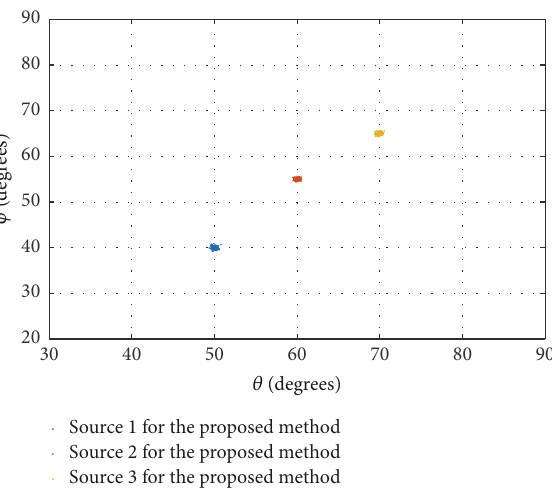
Figure 10: Scatter plot for the proposed method in the presence of three noncoherent sources located at (𝜃 1 = 50 ∘ , 𝜙 1 = 40 ∘ ) , (𝜃 2 = 60 ∘ ,𝜙 = 55 ∘ ) , and (𝜃 = 70 ∘ ,𝜙 = 65 ∘ ) with SNR = 20dB. 2 3 3